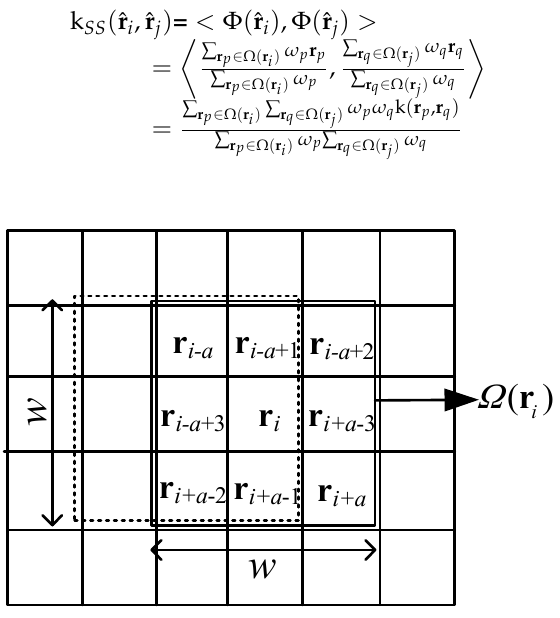
Figure 2. The local sliding window Ω ( r i ).